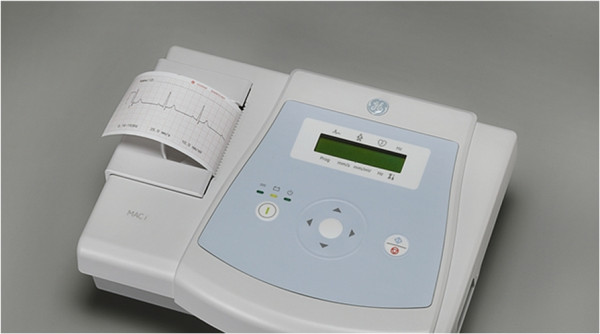
General electric MACi ECG machine [7].